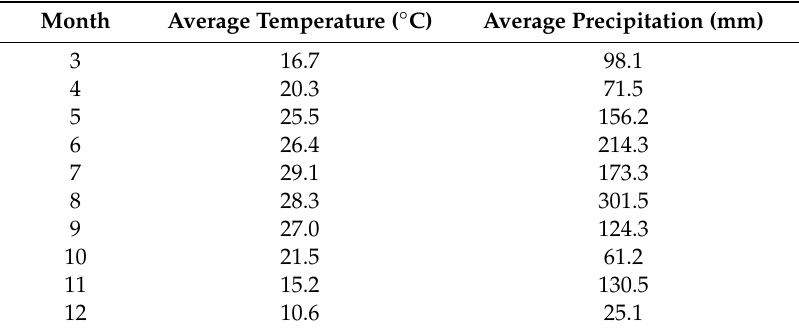
Table 1. The experiment environmental condition in 2018.